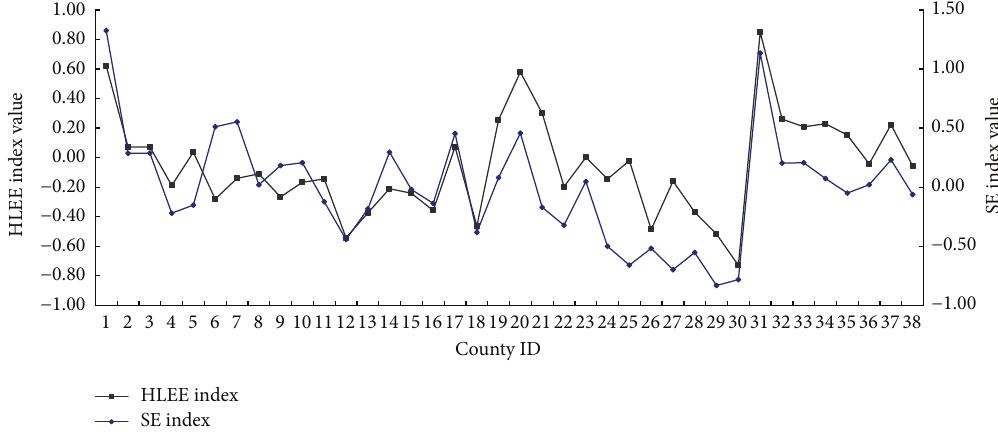
Figure 5: The curve of human living environmental evaluation (HLEE) index and socioeconomic evaluation (SE) index (county ID is the same as it in Figure 2).